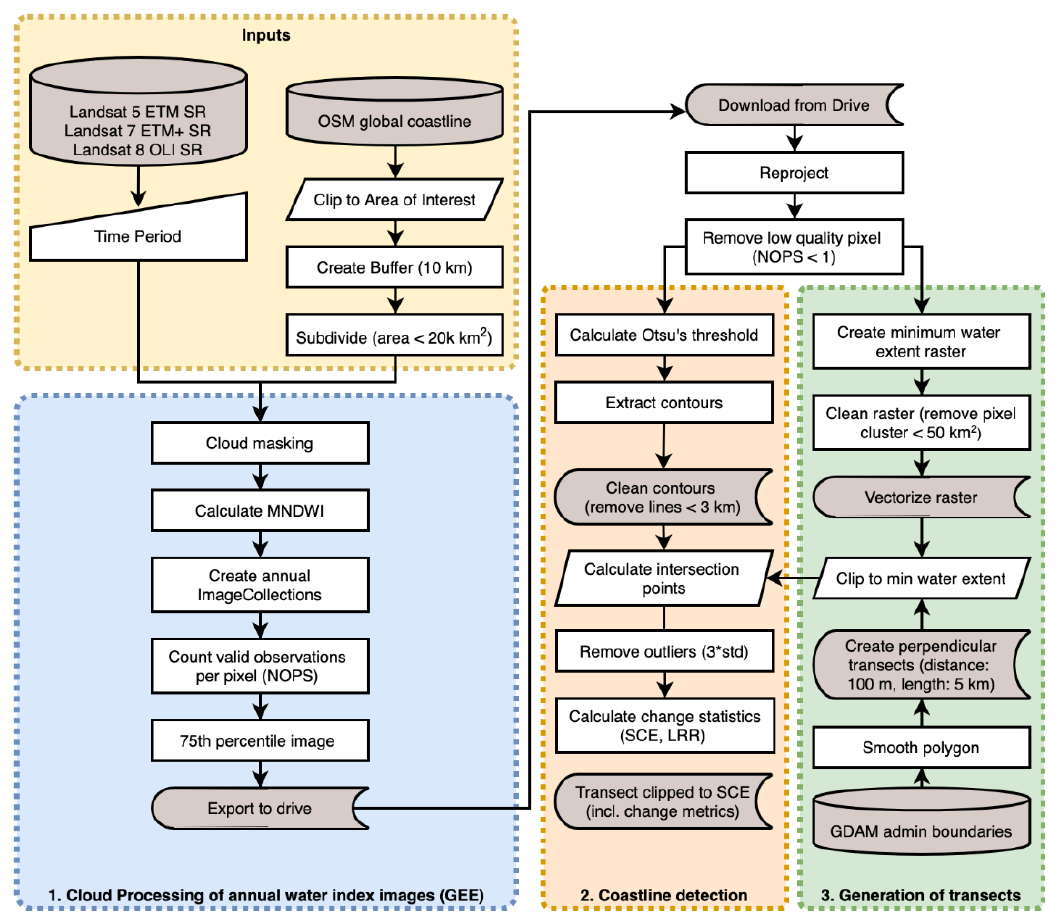
Figure 3. Schematic workflow of the coastline detection method.